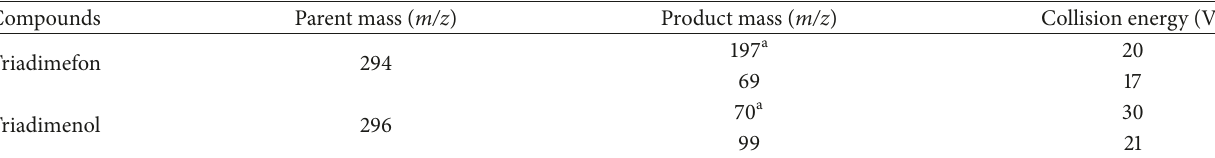
Table 2: SRM conditions for target compounds.